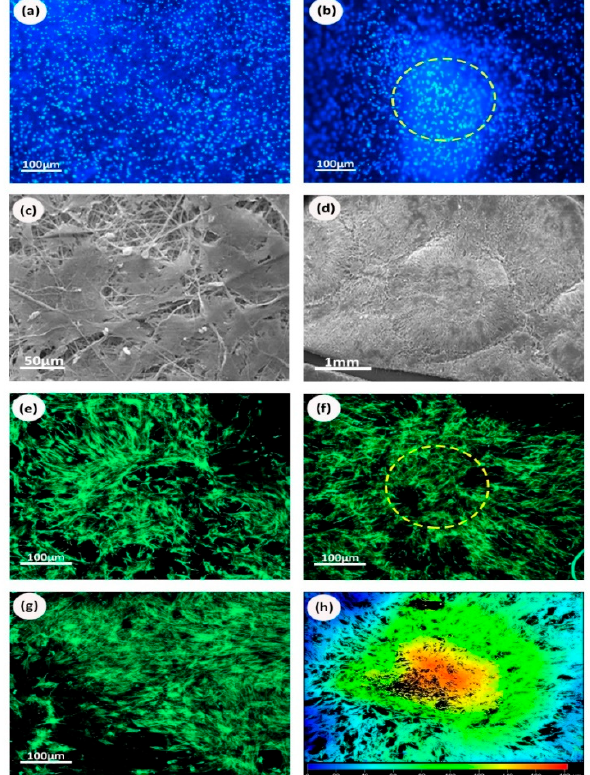
Figure 8. Cell morphology and distribution on scaffolds functionalized with BG: ( a ) fluorescent microscopy of nuclei DAPI staining (blue) of plain samples with 10% BG; ( b ) fluorescent microscopy image of nuclei DAPI staining (blue) of niche samples with 10% BG; ( c ) SEM micrographs of 30% BG plain samples; ( d ) SEM micrographs of niche samples with 10% BG; ( e ) confocal microscopy of niche 10% BG; ( f ) confocal microscopy of niche bottom 30% BG; ( g ) Confocal microscopy of plain 10% BG; ( h ) heat map of confocal imaging microscopy for niche structure, each color indicates a specific depth of cell penetration. Cells appear to penetrate as deep as 180 µ m at the center of the niche (red area), while around the niche edge they exhibit superficial expansion (blue area).